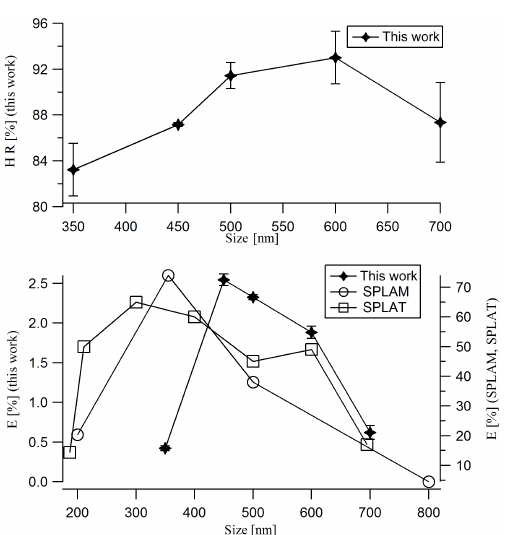
Figure 6. The scattering efficiency and the hit rate as a function of the size of various PSL particles (350, 450, 500, 600, and 700nm) at a particle number concentration of 20cm − 3 . The SPLAT and SPLAM scattering detection efficiency results are given for com- parison